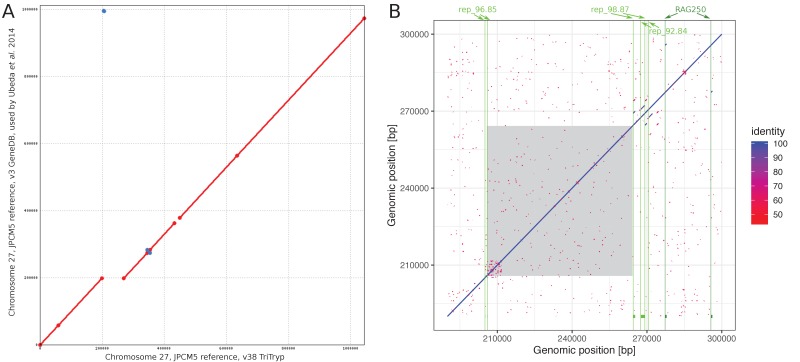
Identification of novel repeated sequences on chromosome 27.(A) Positions 199,468–269,164 in the L. infantum JPCM5 reference genome (TriTrypDB, (v38) were not present in the reference assembly used by Ubeda et al. (2014). (B) Repeated sequences within chromosome 27, positions 190,000–300,000 in the reference genome, JPCM5 (TriTrypDB v38). The dot plot shows the comparison of the sequence region against itself. Similar sequences are coloured by their % identity. The grey shaded area indicates the common deletion found in a subset of all our strains (Figure 7A, Figure 7—figure supplement 7A). Green bars at the bottom indicate the location of repeat regions with a vertical line indicating their start position. Dark green indicated repeats originally described in Ubeda et al. (2014) and light indicates newly identified repeats. Coordinates of the newly identified repeats are summarised in Supplementary file 13.